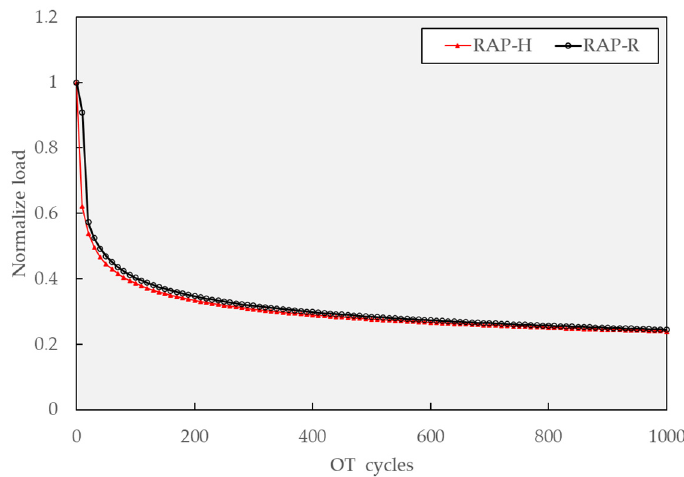
Figure 12. Normalized load reduction curve between RAP-H and RAP-R. Table 10. Result of crack resistance